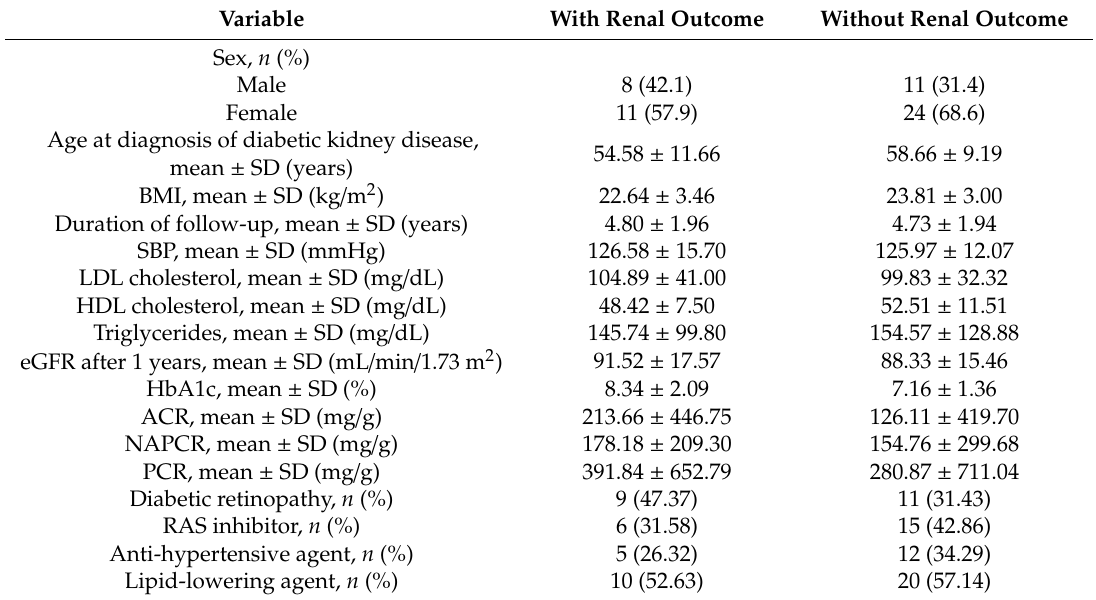
Table 1. Baseline characteristics of the patients with type 2 diabetes (T2D) with and without renal